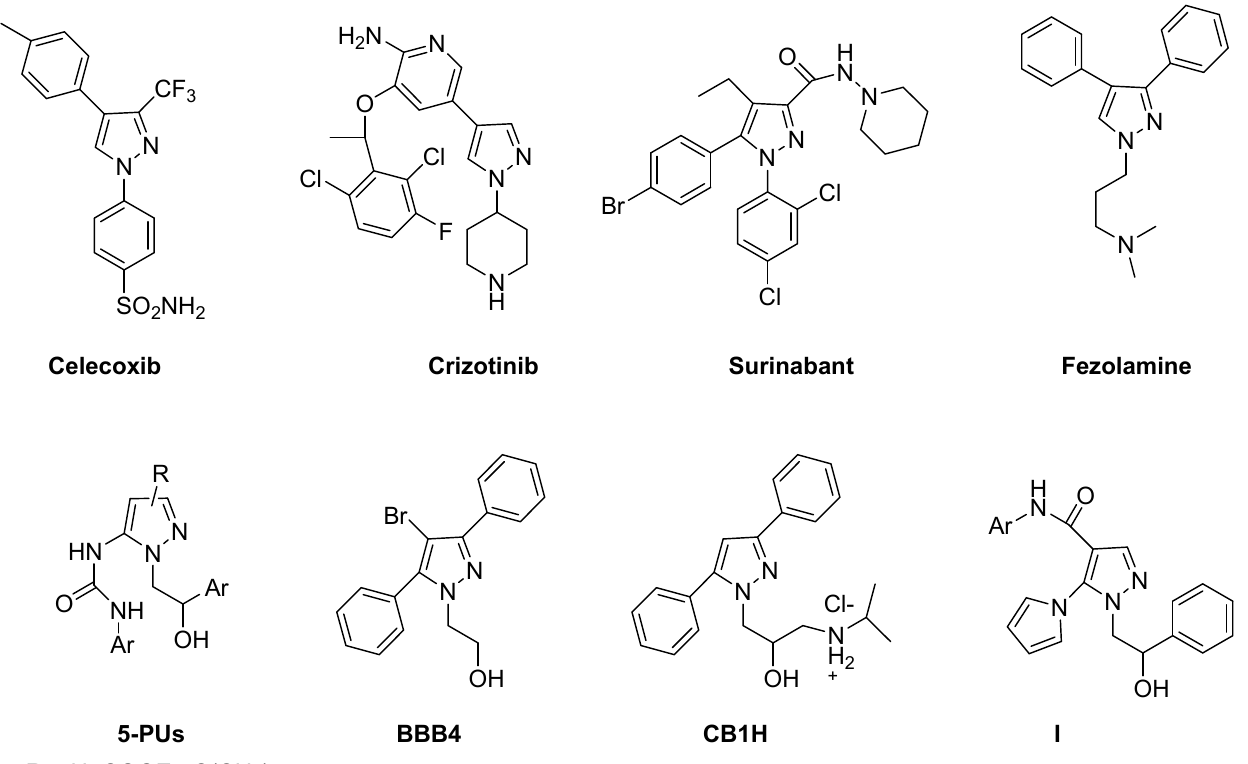
Figure 1. Chemical structure of some drugs endowed with the pyrazole structure (Celecoxib, Crizotinib, Surinabant, Fezolamine) and 5-PUs , BBB4 , CB1H and I previously reported as anticancer/anti-inflammatory, antibacterial and anti- Mycobacterium compounds, respectively. Additionally, we have observed that the water solubility and antibacterial effects of two differently functionalized pyrazoles synthetized by us ( BBB4 and CB1H ) (Figure 1) were remarkably improved by their encapsulation in polyester-based dendrimer nanoparticles (NPs) and in styrene-based copolymer NPs [6,14]. In particular, the obtained